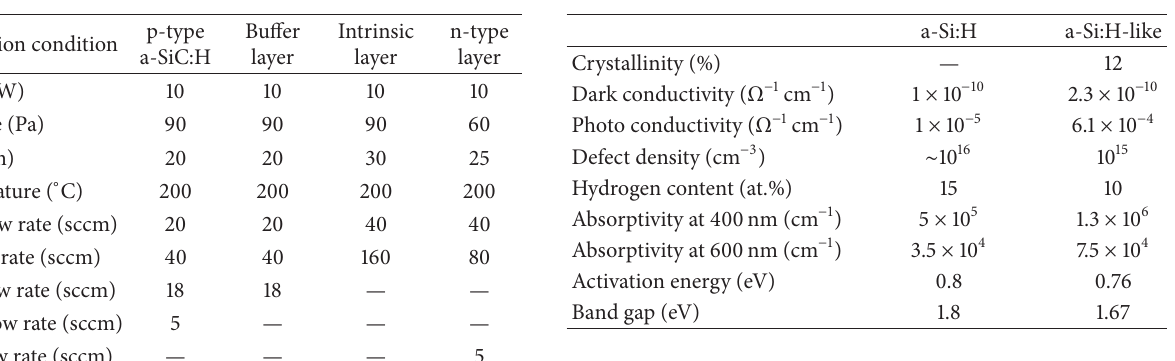
Table 2: The properties of a-Si:H-like films compared to those of typical a-Si:H films.